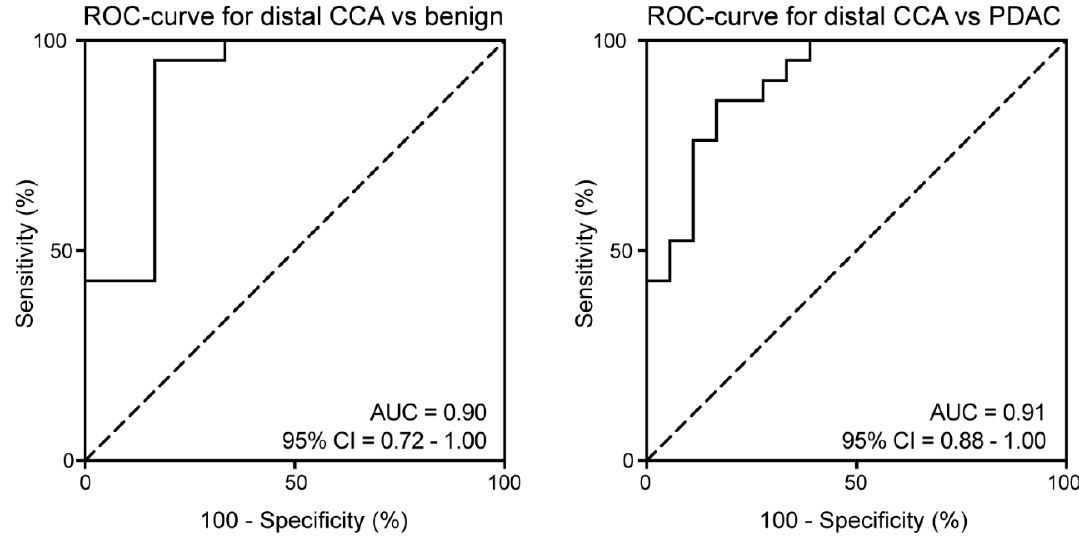
Figure 5. Stratification of patients with high bilirubin levels did not affect the performance of the two-miRNA panel. The two-miRNA panel showed an AUC of 0.90 in patients with elevated bilirubin levels for discriminating patients with distal CCA from benign disease (left) and 0.91 for distal CCA from PDAC (right).